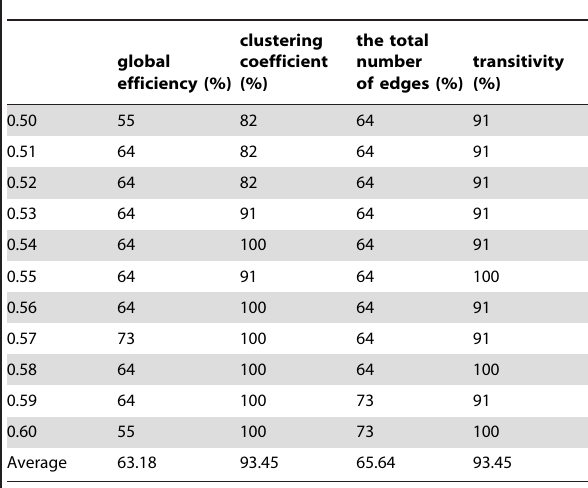
Table 2. Classification